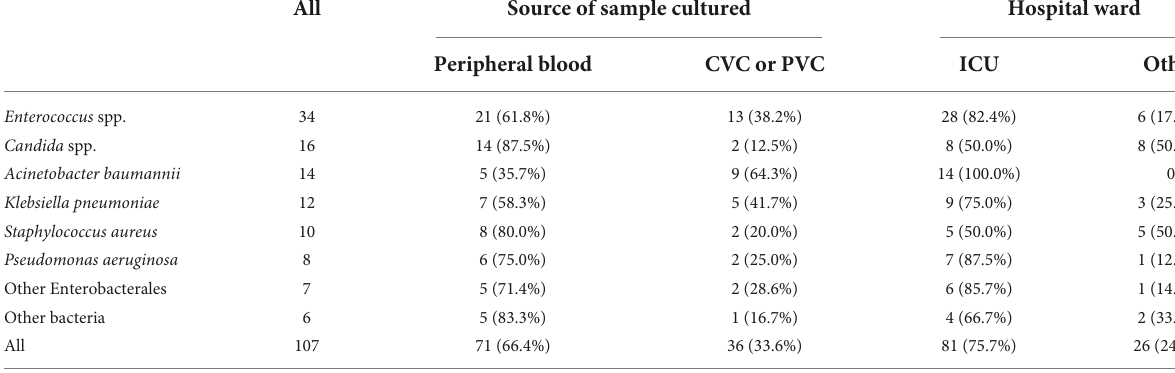
TABLE 5 Time from admission to positive blood culture and time from positive blood culture to death, by isolated microorganism. Time (days) from positive blood culture to death: Microorganism Time (days) from admission to positive blood median culture: median (IQR)